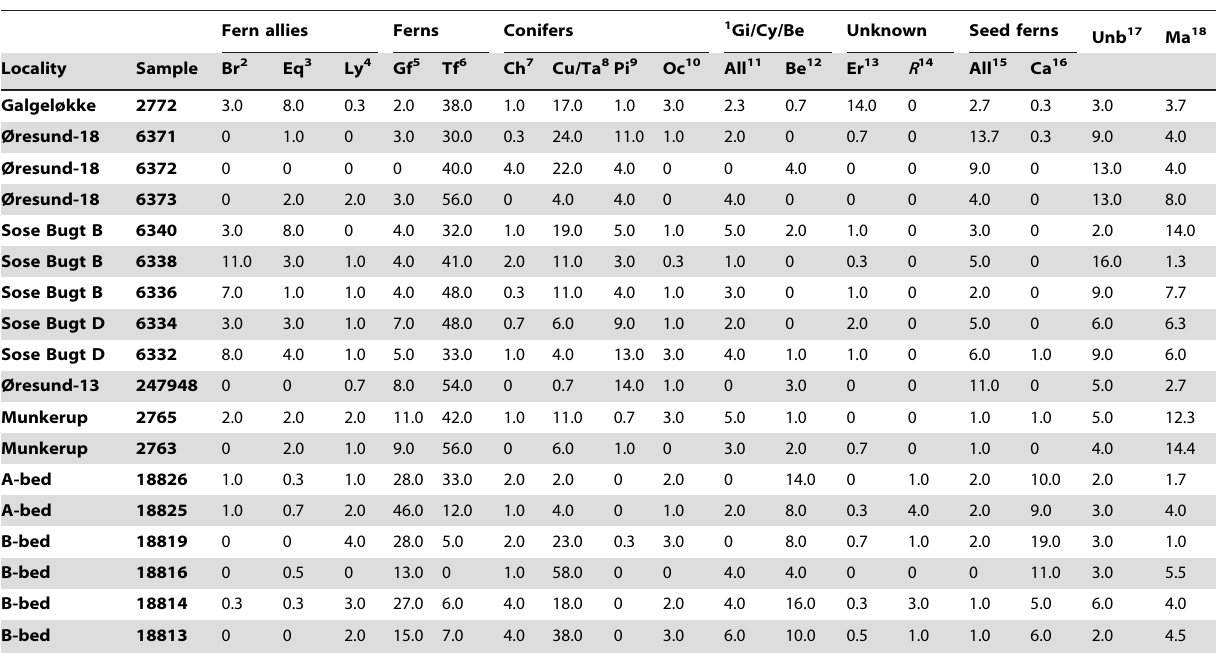
Table 2. Coal/coaly bed relative palynomorph abundance data arranged after parent plant affinity.